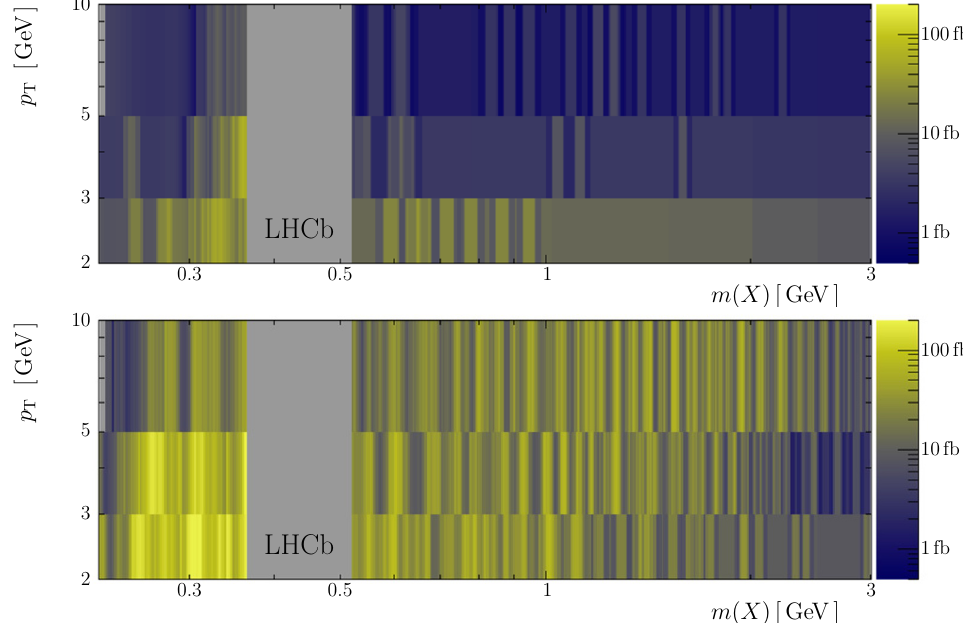
Figure 9 . Upper limits at 90% con(cid:12)dence level on the cross section (cid:27) ( X (top) promptly produced and (bottom) inclusive searches for displaced X